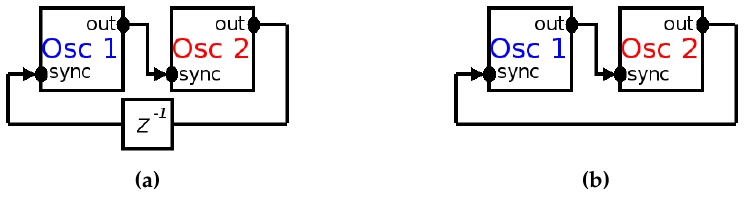
Figure 2. Block diagrams showing the signal flow for reciprocal sync. Using dyamical oscillators. ( a ) Using lookup oscillators; ( b ) Using dyamical oscillators.